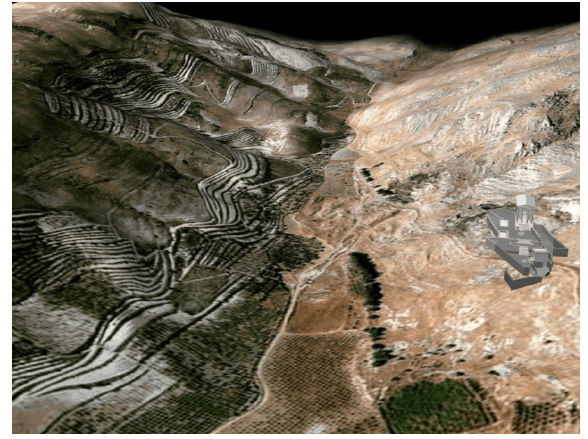
Figure 11. The Terrain model with the integration of the Hosn-Niha sanctuary. © J. Yasmine;